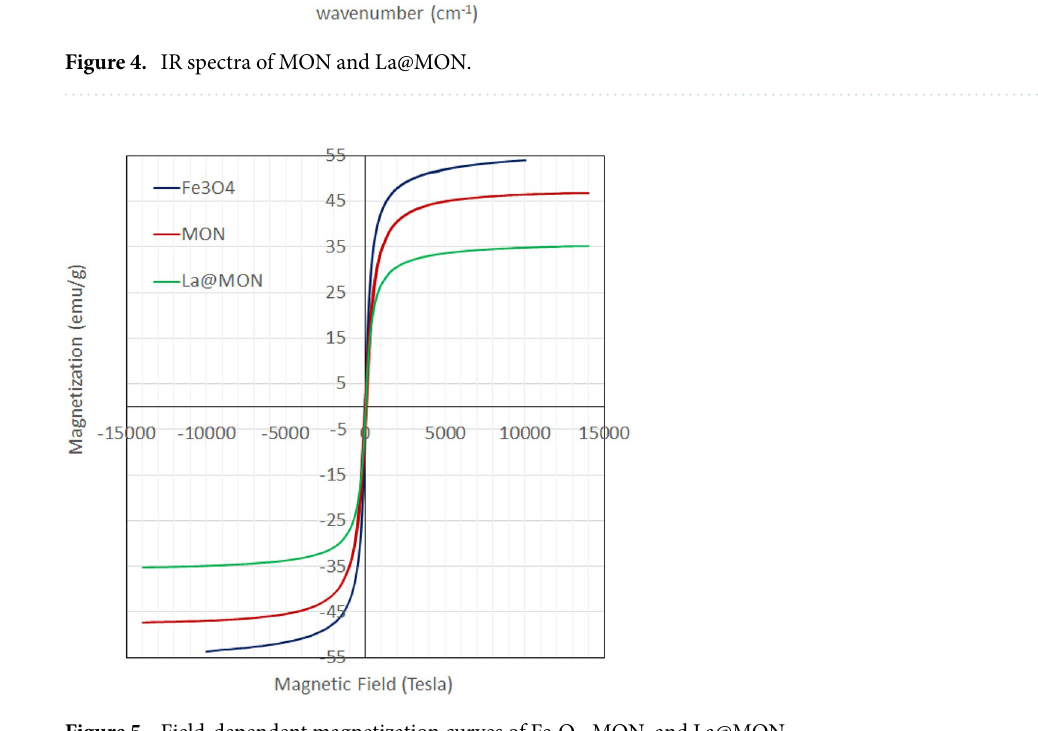
Figure 5. Field-dependent magnetization curves of Fe 3 O 4 , MON, and